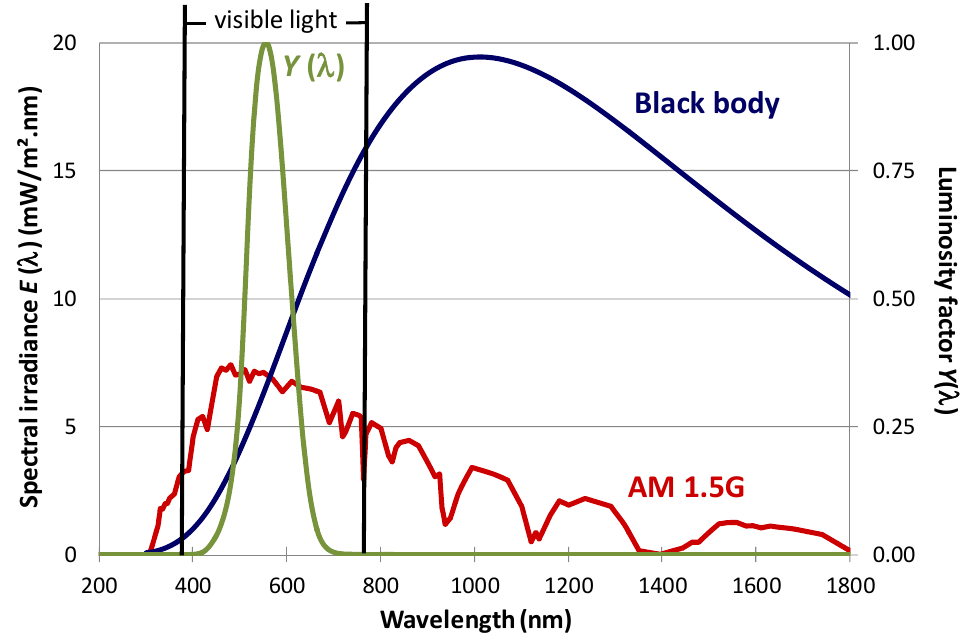
Figure 1. Axis left: the spectral irradiance E ( λ ) of the solar spectrum AM 1.5G and of a black body on temperature T = 2856 K, both scaled to 500 lux. Axis right: the luminosity factor Y ( λ ). The region of the visible light is